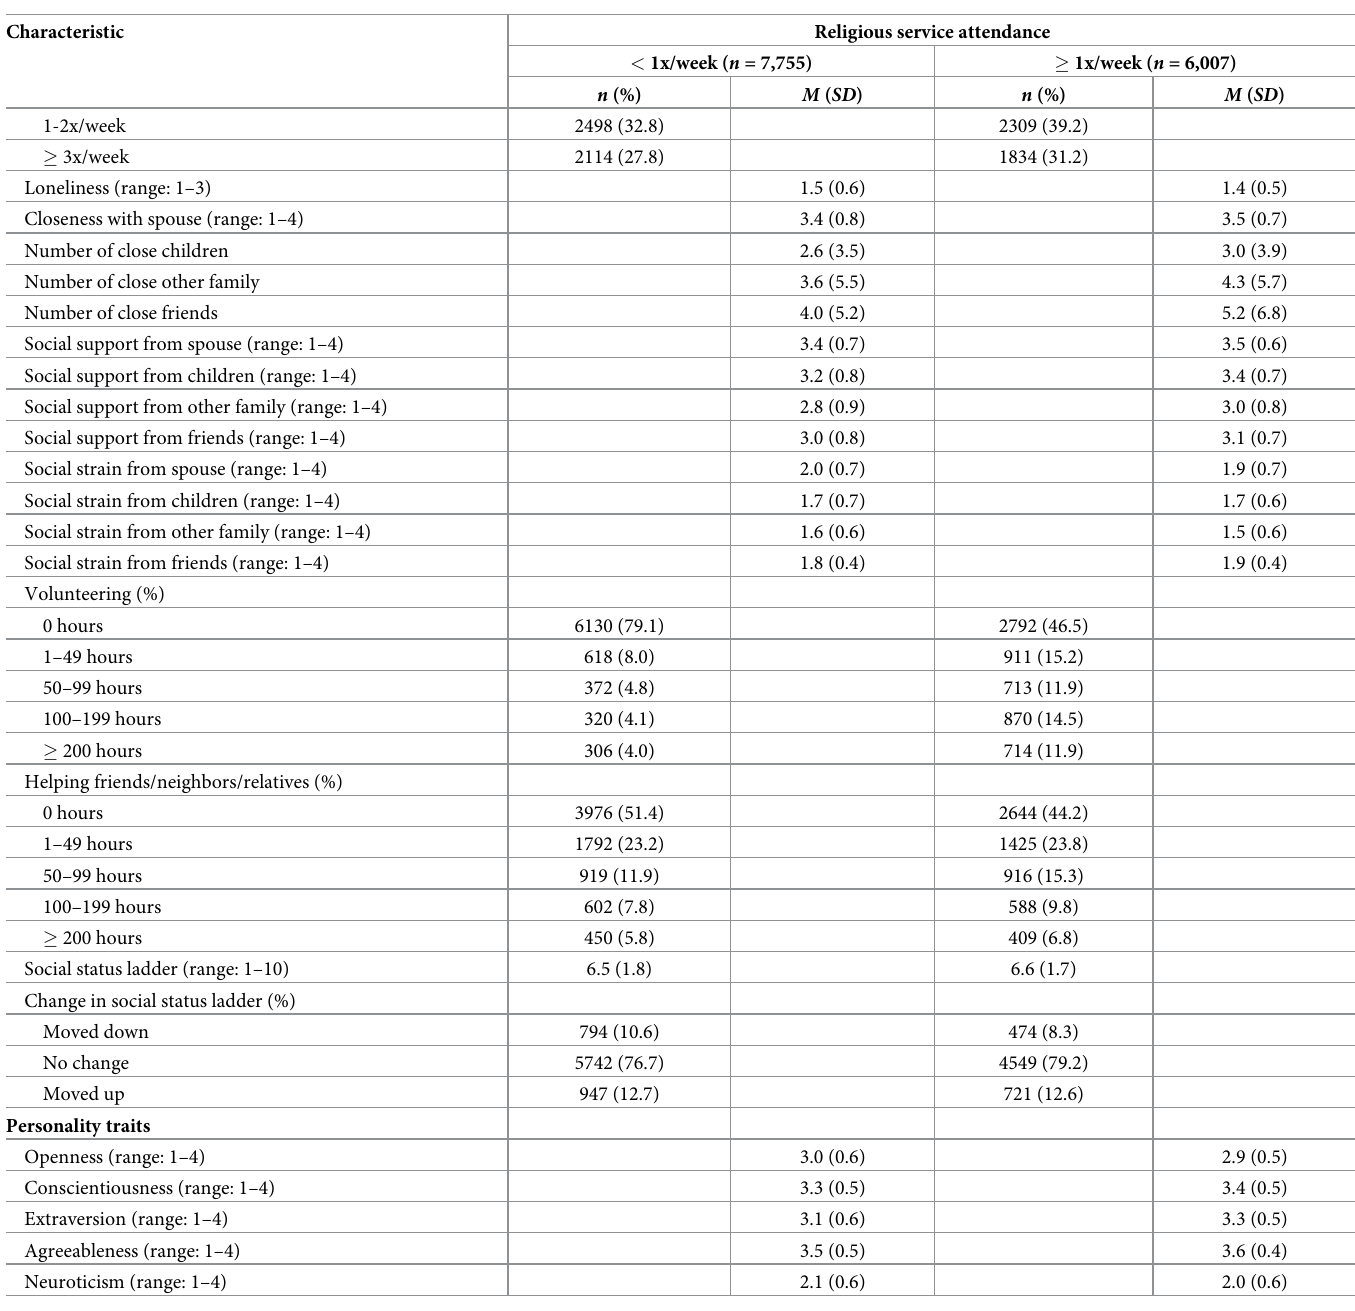
Table based on non-imputed data ( N = 13,762). b All variables were assessed in 2006/2008 (T 0 ) and used as covariates. c Cumulative percentage for some variables may not add up to 100% due to